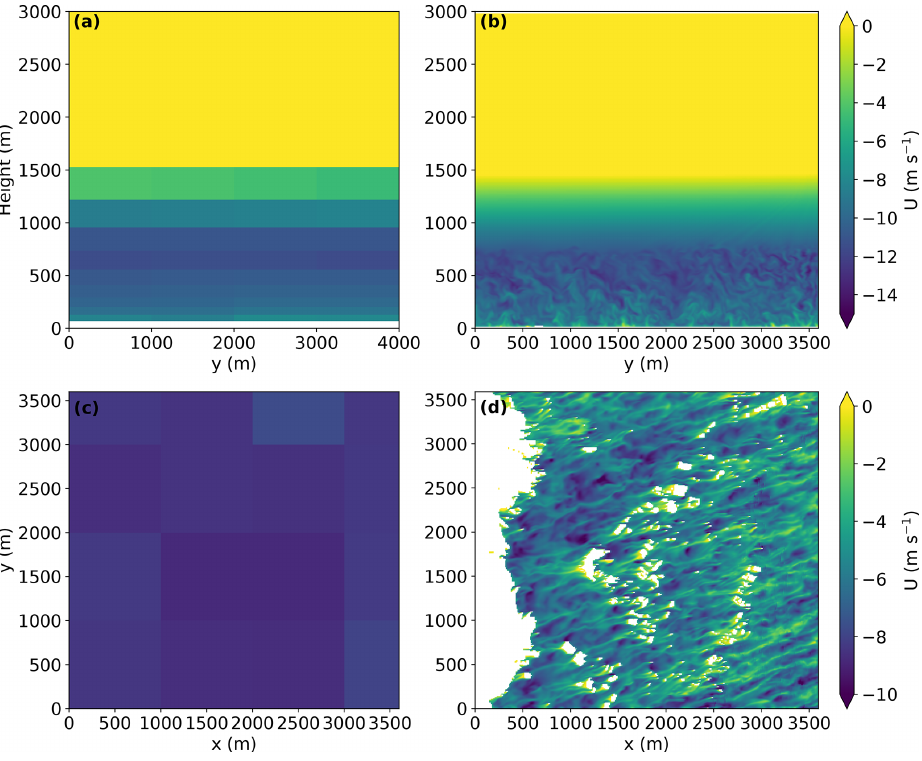
Figure 13. As in Fig. 7, but at 16:00NZDT, 16 May 2017 for the north-easterly case.